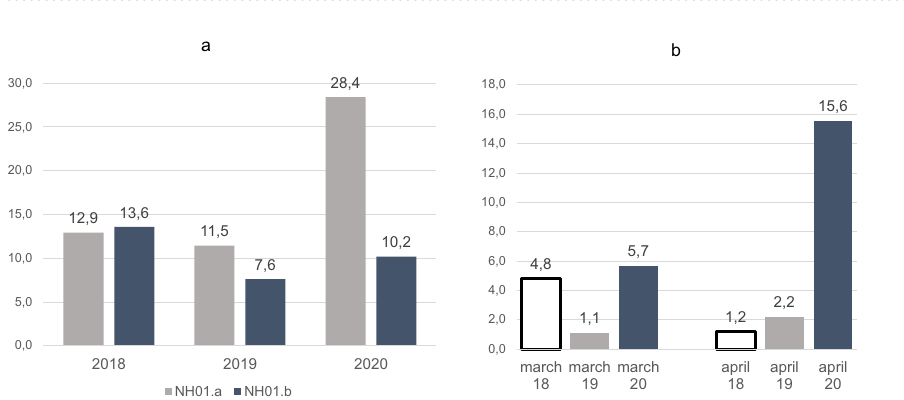
Figure 10. COVID-19-related deaths by age group in Berlin Neukölln. Data are given in deaths per calendar week per 100,000 of age group.